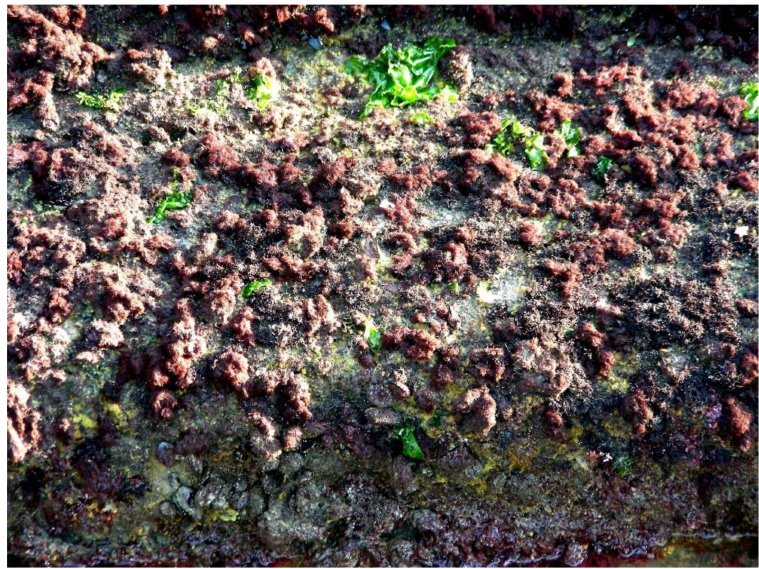
Figure 3. Tufts of Caulacanthus okamurae covering hard substrata in the Venice